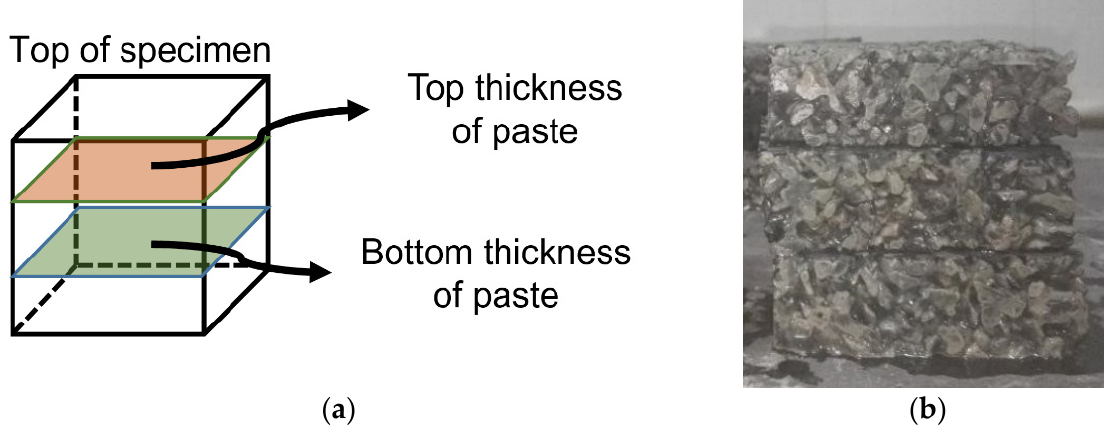
Figure 7. ( a ) The diagram of the method of cutting the surfaces for the thickness distribution of the paste analysis, and ( b ) the real specimen after cutting.